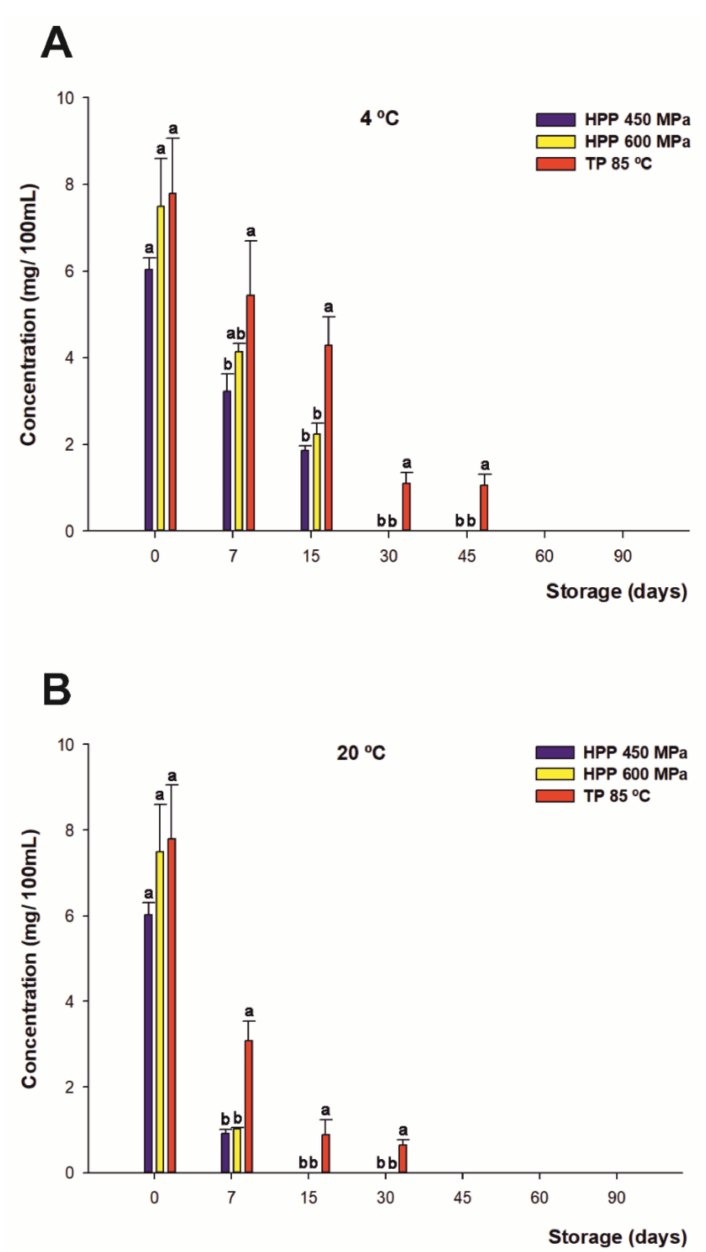
Figure 1. Changes in content of vitamin C (mg/100 mL) for juices subjected to high hydrostatic pressure (HHP—450 MPa and HHP—600 MPa) and thermal pasteurization (TP—85 ◦ C), measured during storage for 90 days under refrigerated conditions at 4 ◦ C ( A ) and 20 ◦ C ( B ) under darkness conditions. Bars with different lowercase letters within each time point were different statistically at p < 0.05 according to the analysis of variance (ANOVA) and Tukey’s multiple range